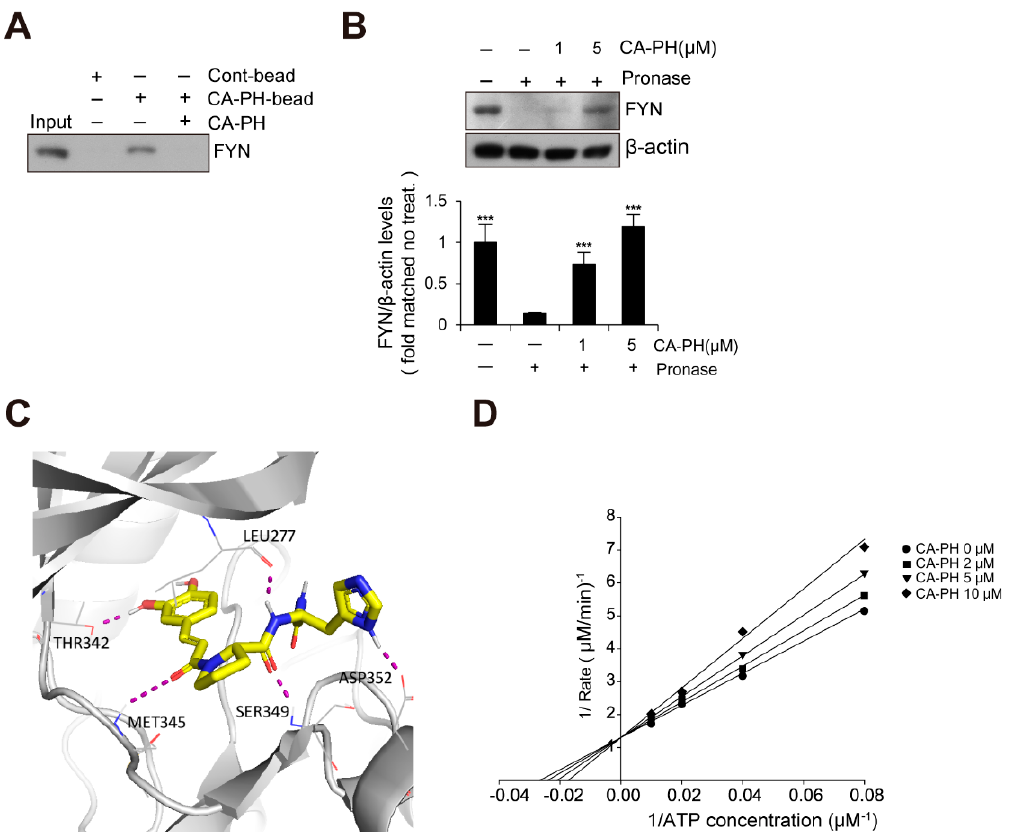
Figure 3. CA-PH binds to and inhibits Fyn. ( A ) CA-PH interacts with Fyn. CA-PH beads were prepared by binding of CA-PH to polystyrene beads (See Materials and Methods). CA-PH-bound beads were mixed with protein extract from HaCaT cells. After extensive washing, Western blotting was performed using anti-Fyn antibody. Free excess CA-PH was added as a competitor. ( B ) The drug a ffi nity responsive target stability (DARTS) assay reveals that CA-PH-bound Fyn is resistant to protease digestion. Protein extract from HaCaT cells was mixed with CA-PH and treated with Pronase at room temperature. Western blot analysis was performed using anti-Fyn antibody. As a loading control, the reaction mixture without incubation was immunoblotted with anti- β actin antibody. Representative images are shown. Data were quantitatively assessed and are additionally depicted in graphs ( n = 3). ( C ) Molecular docking shows that CA-PH binds to the ATP binding site of Fyn ( ∆ G = − 8.74 kcal / mol). CA-PH can form 5 hydrogen bonds with Leu277, Thr342, Met345, Ser349, and Asp352 residues ATP. Double-reciprocal plots of the inhibitory activity of CA-PH. Fyn kinase activity was measured at 1 / (ATP). Km = 40.4 µ M, Ki = 16 µ M. Fyn kinase assay was performed using a Kinase Enzyme System. For enzyme kinetics, the Lineweaver–Burk method was applied. All data represent means ± S.E.M. Significance value was *** p ≤